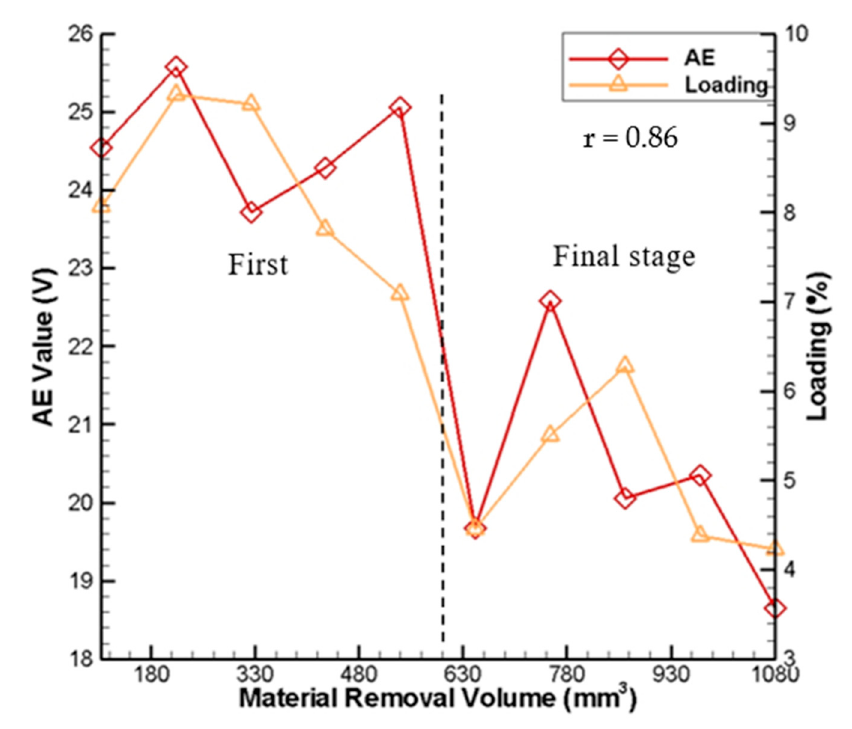
Figure 9. Measured wheel loading over grinding wheel surface and captured wheel loading images.